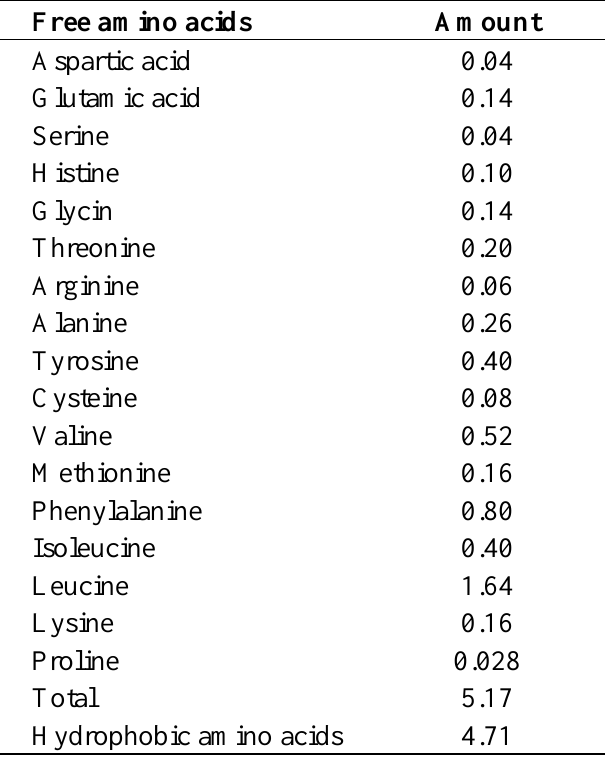
Table 3. Free amino acids content (g/100 g) of Flavourzyme